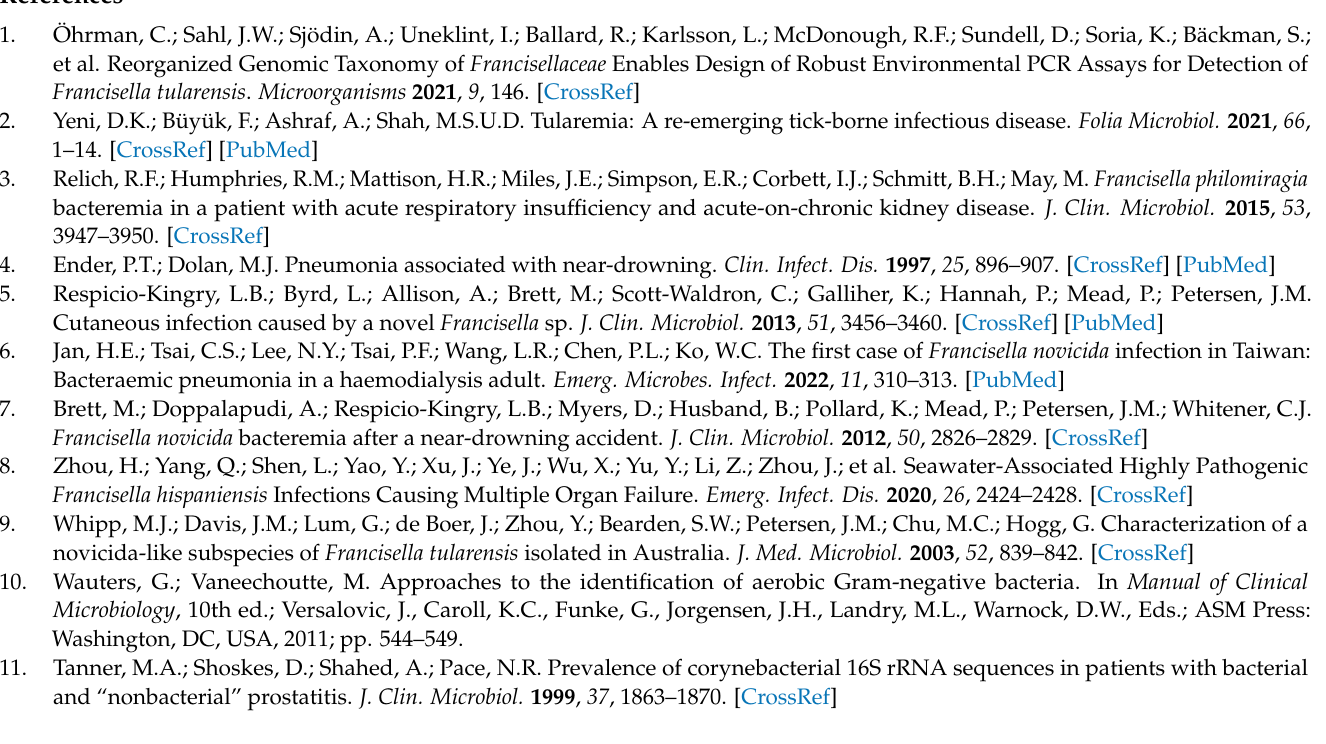
Table S2: Predicted virulence factors based on the VFDB analysis in F. philomiragia strain IDAMR664. Supplementary File S1: Genomic comparison of F. philomiragia strains IDAMR664 and GA01-2794 using the Mauve